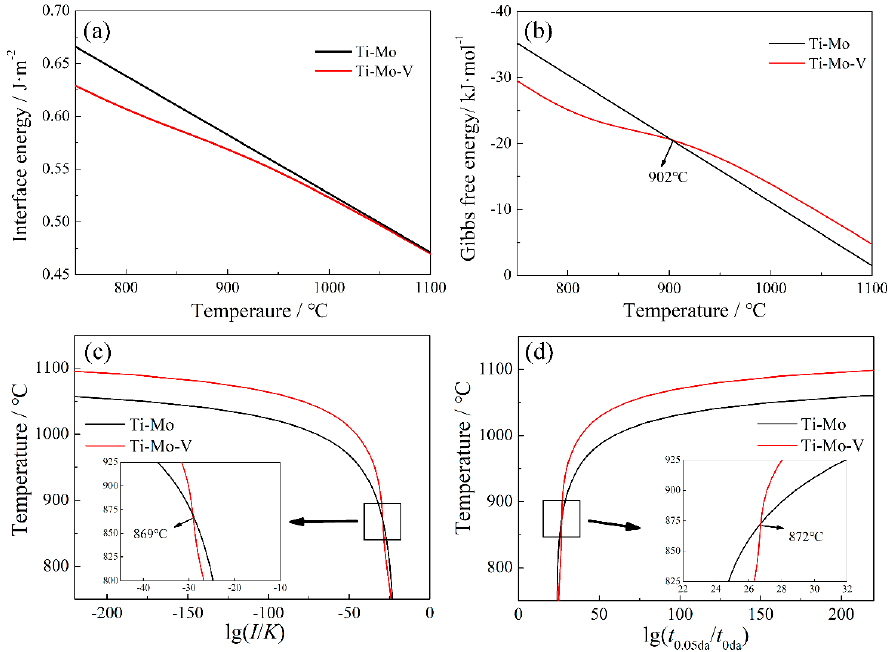
Figure 7. The kinetic analysis in austenite of Ti − Mo and Ti − Mo − V steels. ( a ) curve of interfacial energy, ( b ) curve of Gibbs free energy, ( c ) curve of NrT and ( d ) curve of PTT.